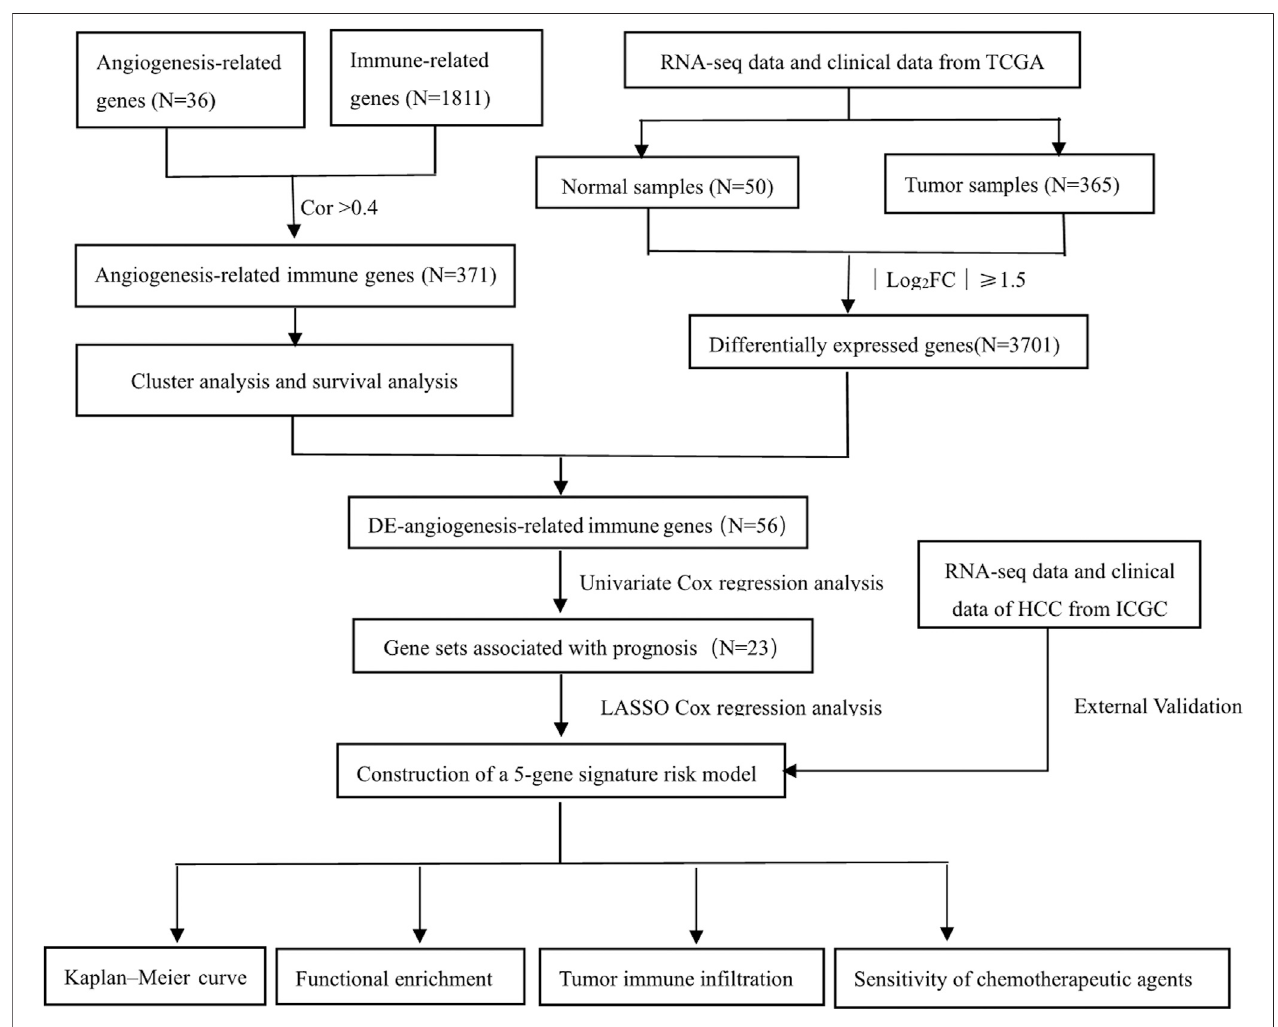
FIGURE 1 | Flowchart of this